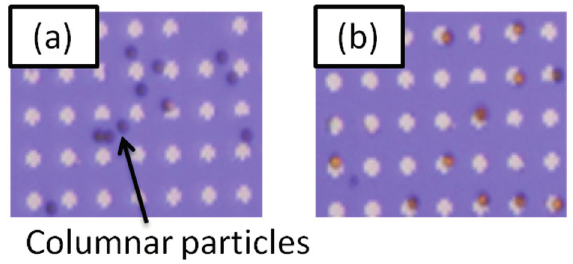
Figure 8. ( a ) Optical microscope image of the random distribution of columnar-beads onto gold arrays in the absence of an external magnetic field; ( b ) distribution of the columnar-beads after application of an external magnetic field of 37 Oe. Adapted from